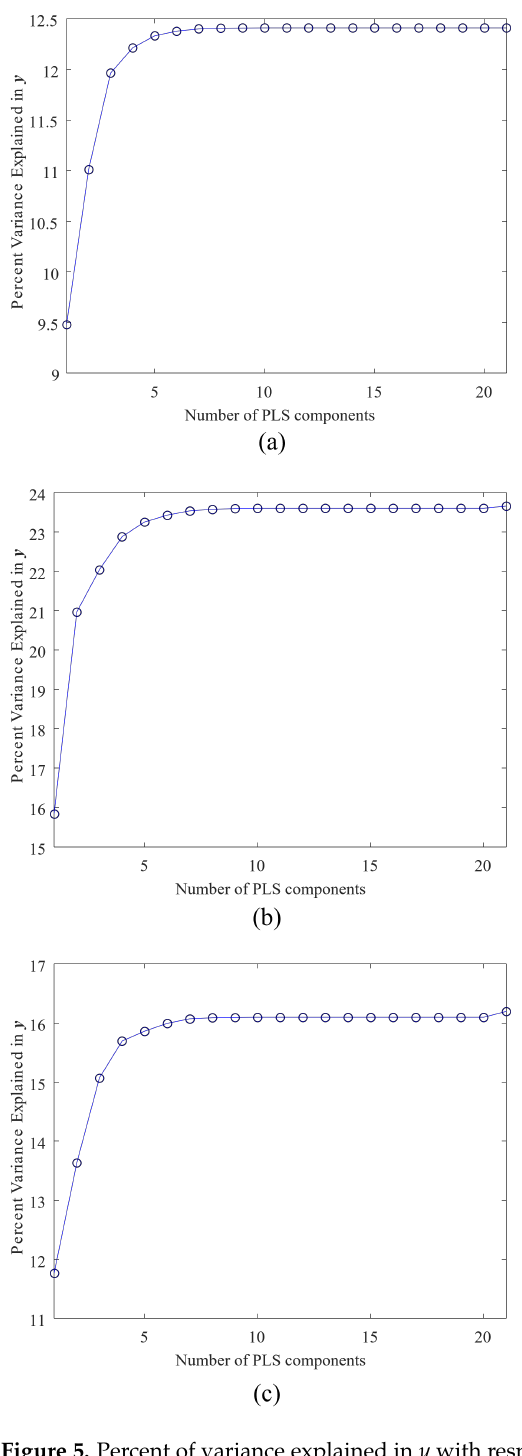
Figure 5. Percent of variance explained in y with respect to the number of PLS components: ( a ) The data of the all participant; ( b ) the data of the student participants from the UCAS, first-class, and national key universities; and ( c ) the data of the students from the ordinary